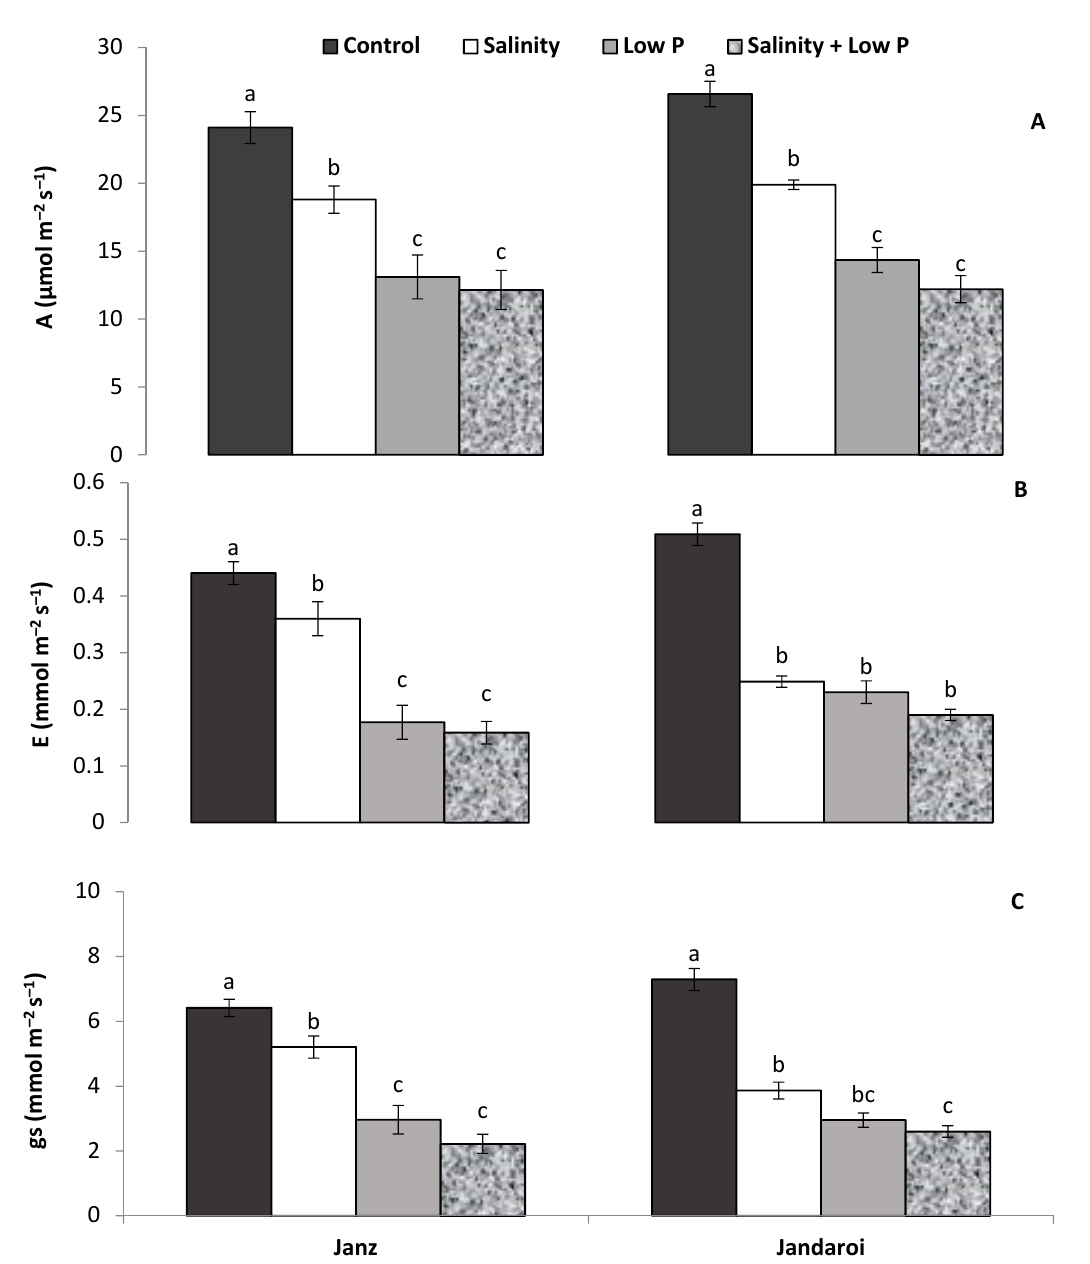
Figure 1. Effects of salinity, low P supply and their interaction on ( A ) net photosynthetic rate, ( B ) transpiration rate and ( C ) stomatal conductance in salt-tolerant (Janz) and salt-sensitive (Jandaroi) wheat cultivars. Values are the means ± SE of three replicates (nine plants). For each cultivar, values sharing the same letter are not significantly different ( p ≤ 0.05).